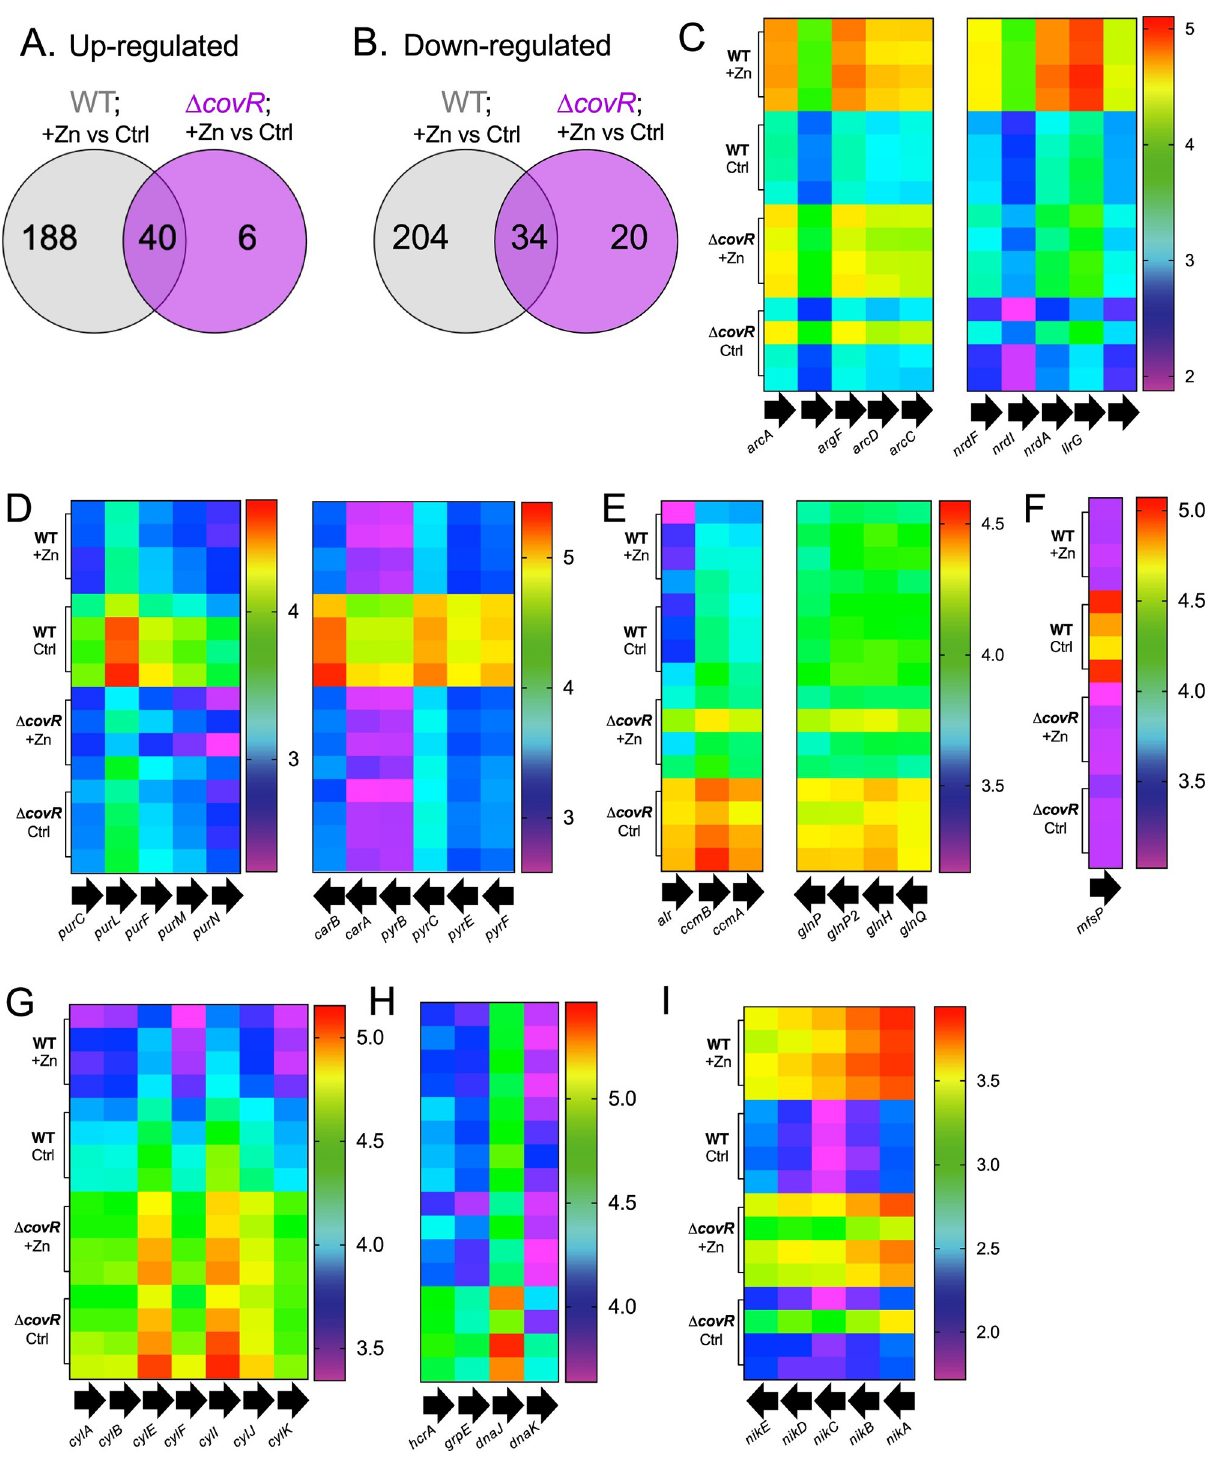
Fig 6. Effect of CovR on GBS transcriptional responses to Zn stress. Venn diagrams comparing the number of up-regulated (A) and down-regulated (B) transcripts that are shared or unique in WT and Δ covR GBS strains during exposure to Zn stress (0.25 mM; +Zn) versus control (THB medium alone). (C to I) Heatmaps displaying log 10 FPKM values (fragments per kilobase million) of selected genes from RNA-sequencing of Δ covR and WT GBS with and without Zn as indicated. Columns represent individual genes and rows are biological replicates ( n = 4), with legends showing colours in log 10 FPKM for each panel as indicated. Black arrows indicate orientation of genes within each loci. The complete lists of genes and transcripts are available as S3 and S4 Data. https://doi.org/10.1371/journal.ppat.1010607.g006 PLOS Pathogens| https://doi.org/10.1371/journal.ppat.1010607 July 21,